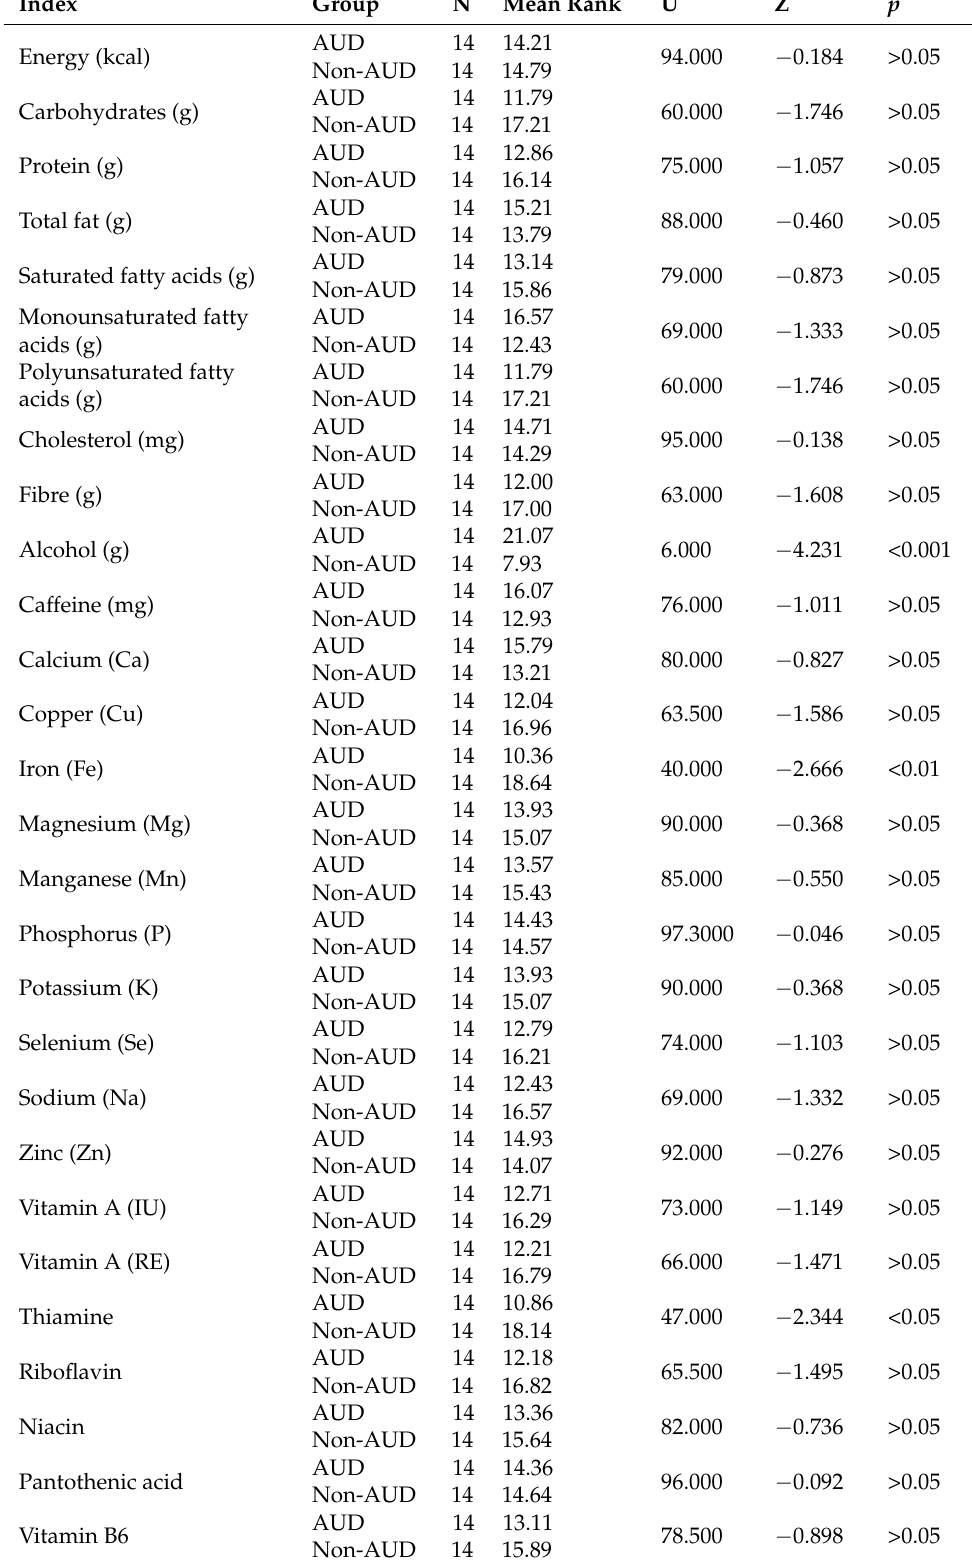
Table 3. Nutrient intake of AUD versus non-AUD